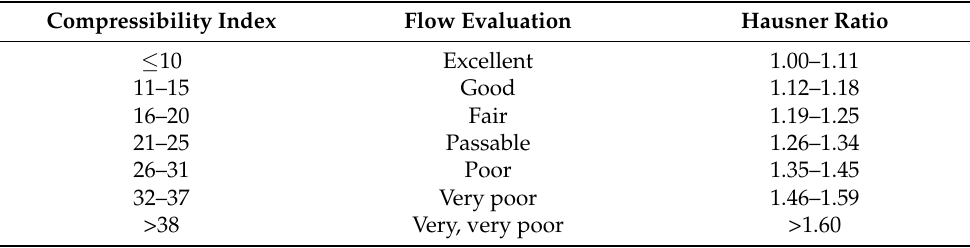
Table 2. Flowability scale accepted and published on the U.S.